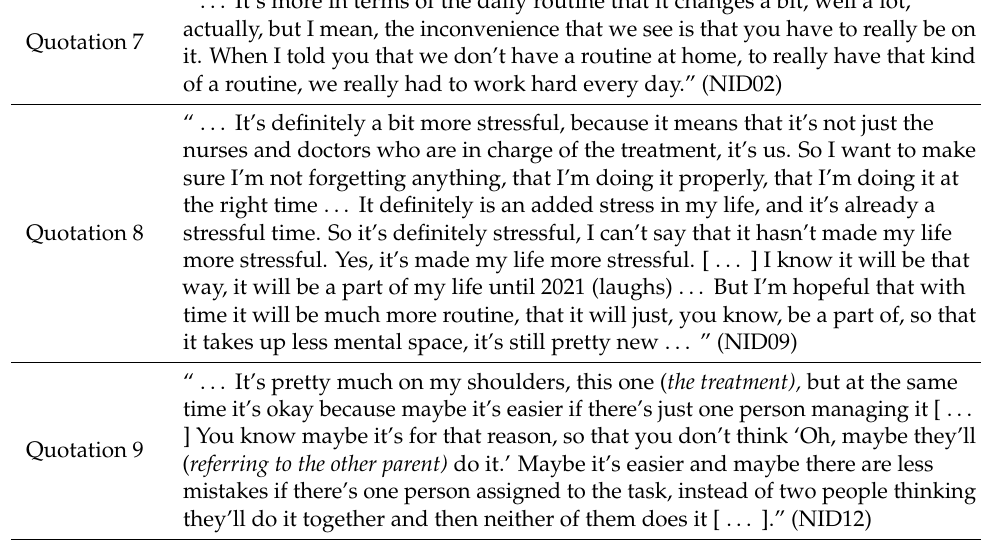
Table 4. Exemplar quotations from interviewed parents for the theme: Developing and maintaining a